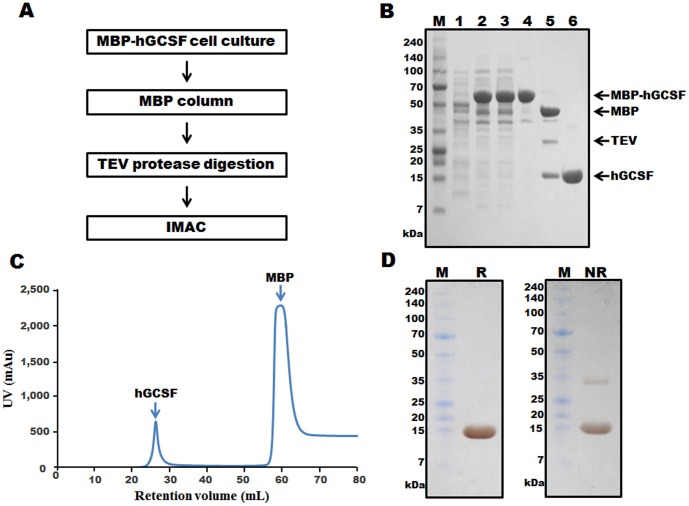
Purification of hGCSF from the MBP-hGCSF fusion protein expressed in E. coli BL21(DE3).A. Overview of the purification process using an MBP affinity column, TEV protease digestion, and IMAC. B. SDS-PAGE analysis of hGCSF at various stages of the purification process. M, molecular weight marker; lane 1, total protein before IPTG induction; lane 2, total protein after IPTG induction; lane 3, soluble fraction after cell sonication; lane 4, MBP-hGCSF fusion protein purified using an MBP affinity column (63.3 kDa); lane 5, MBP-hGCSF fusion protein after cleavage with TEV protease showing separated MBP (40.3 kDa) and hGCSF (18.8 kDa); lane 6, purified hGCSF after IMAC (18.8 kDa). C. IMAC chromatogram of the TEV protease cleaved MBP-hGCSF fusion protein showing clear separation of the MBP tag and hGCSF. D. Silver staining of 7.5 µg of purified hGCSF. M, molecular weight marker; R, reduced hGCSF; NR, non-reduced hGCSF.